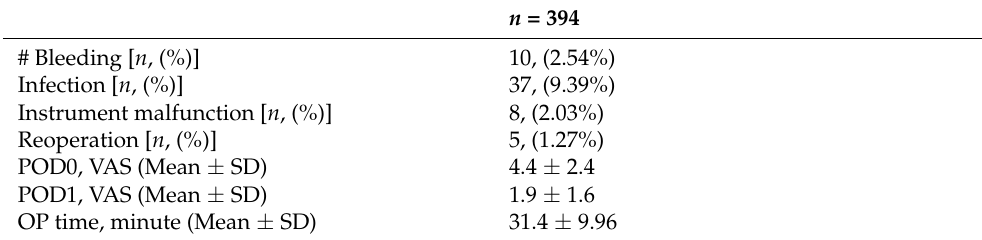
Table 2. Post-operative data in the general